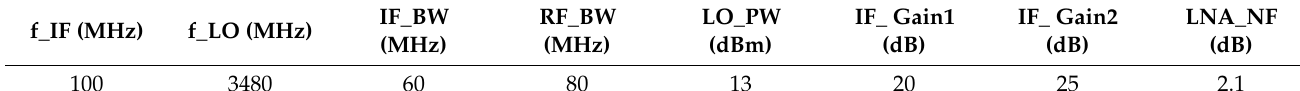
Table A1. Parmeters Used RF TX and RX Models.